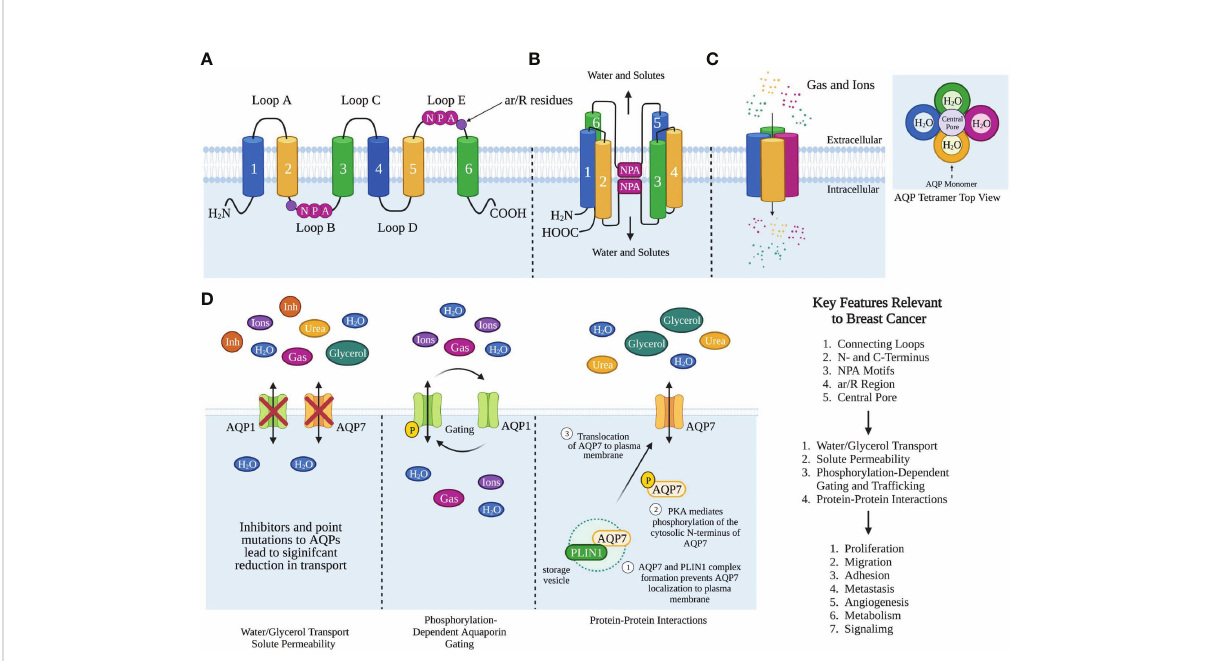
FIGURE 1 Aquaporin Structure and Function Relevant to Breast Cancer. (A) Cartoon representation of AQP monomer topology. The transmembrane helices 1-6, extracellular loops (A, C, E) , intracellular loops (B, D) . Singled-letter N-P-A codes in pink circles mark the NPA motifs and ar/R in purple circles. (B) Organization of helices and NPA motifs on the loops bend to pair with each other and form the water channel monomer. (C) AQP monomers assemble as homotetramers to form a central pore. The structure of AQP homotetramer from the top view shows each AQP monomer containing an independent water pore. (D) AQP functions that are relevant to breast cancer. Created with BioRender.com. Figures (B, C) were modi fi ed from Reference (12) with permission. Figure (D) was modi fi ed from reference (9) with